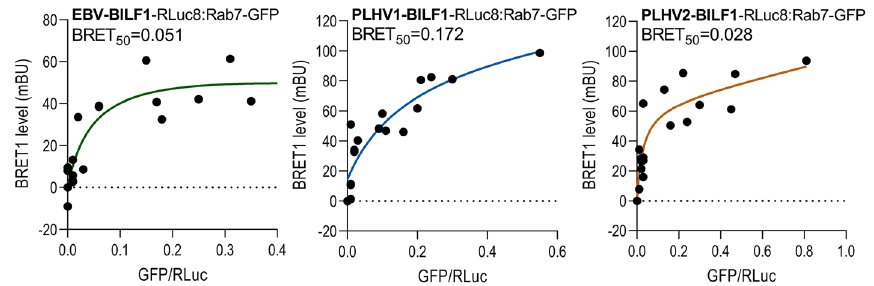
Fig. 5 BILF1 receptors interact with Rab7 protein. BILF1 receptors C-terminally tagged with RLuc8 and various concentrations of Rab7-EGFP protein were expressed in HEK-293A cells. BRET1 values are plotted as a function of the ratio between the GFP (total fluorescence) and RLuc8 (total luminescence) signal. Results are fitted using a nonlinear regression equation. BRET 50 represents the acceptor/donor ratio at 50% of the BRET max , indicating the relative affinity of the acceptor (BILF1-RLuc8) for the donor molecules (Rab7-EGFP). Graphs represent the mean ( SEM) from at least three independent ±